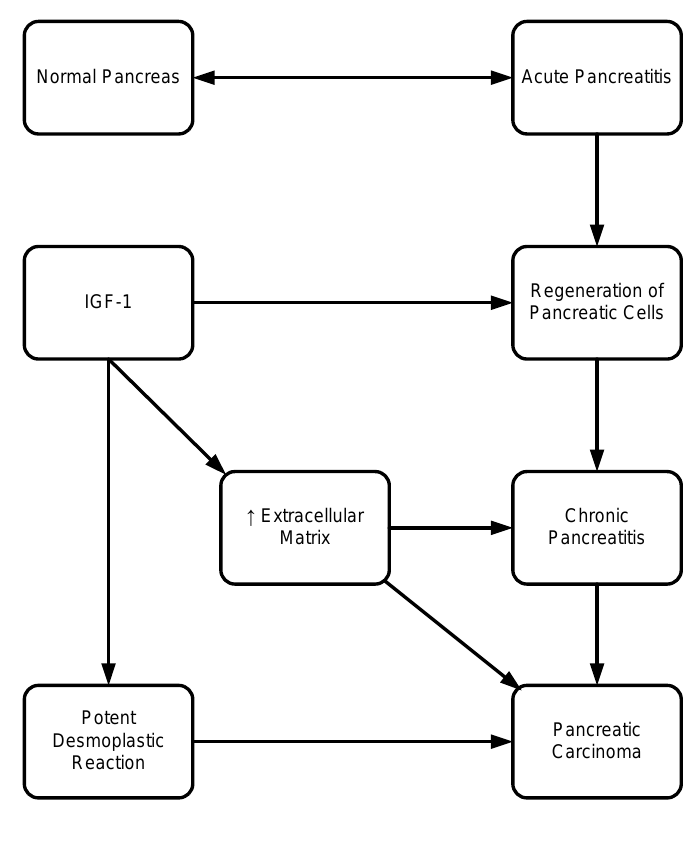
Figure 4. The role of IGF-1 in promoting a strong desmoplastic reaction leading to pancreatitis and, thus, promoting pancreatic